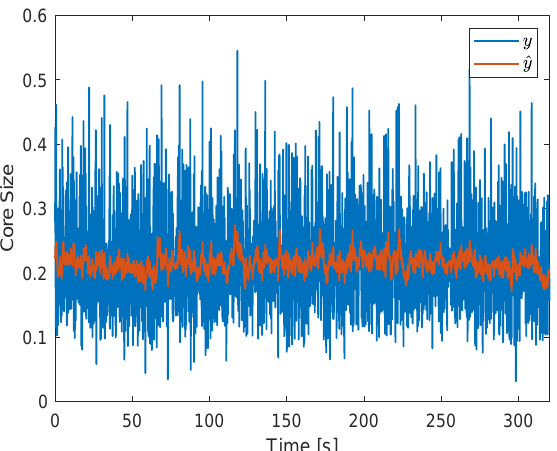
Figure 22. Core size obtained for an air flow rate of 110Ln/min and a water flow rate of 113 L/min at fixed valve positions, which maximize η m . In blue: original ERT signal. In orange: output of the low-pass filter ( ω f = 1 rad/s). Signals with standard deviation σ ( y ) = 0.0724 and σ ( ˆ y ) = 0.0146.